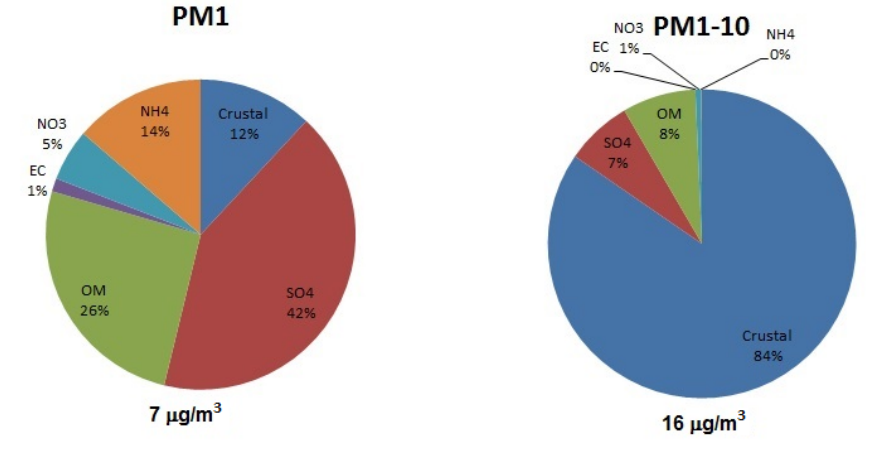
Fig. 7. Reconstructed mass for the 18 May episode, separated into the fine (left) and coarse (right) fractions. The reconstructed mass is Figure 7. Reconstructed mass for the May 18 episode, separated into the fine (left) and coarse 2 indicated below the figure. The total PM 10 reconstructed mass was 23µgm − 3 (right) fraction. The reconstructed mass is indicated below the figure. The total PM10 3 reconstructed mass was 23 µg m -3 .4